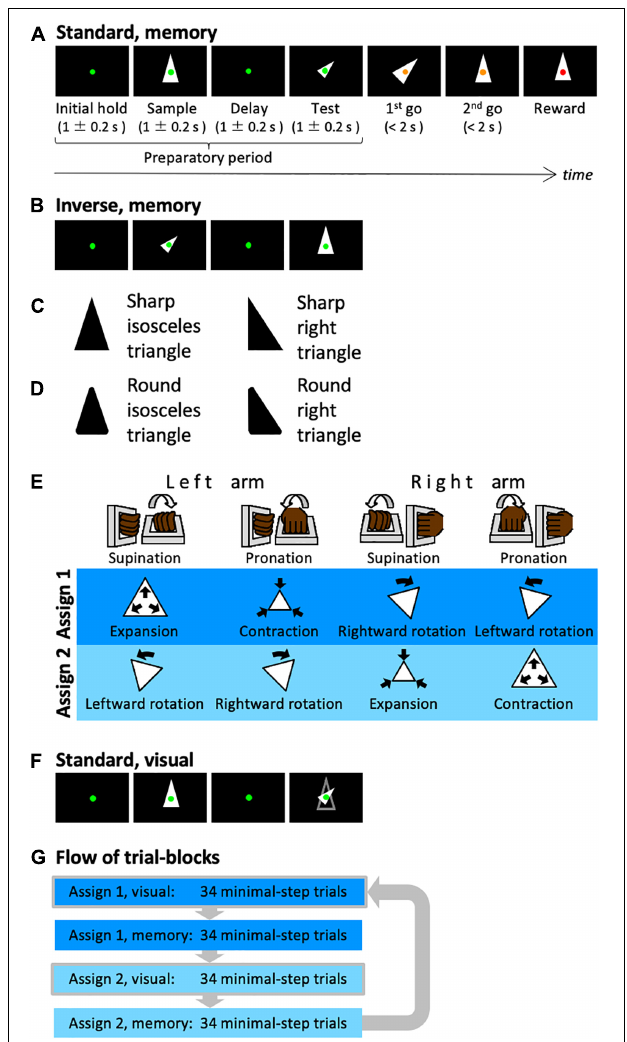
FIGURE 1 | Shape manipulation task. (A) The time-course of one trial. In this case, a shape with standard size and upward orientation was presented in the sample period, while the transformed shape was presented in the test period (standard version). (B) In this case, the transformed shape was presented in the sample period. (C) The types of the presented shapes. An isosceles or right triangle was used. (D) The local features of the presented shapes. Sharp or round corners were used. (E) Assignments between arm movements and manipulation of the shape. (F) In this case, the contour of the sample shape was presented in the test period (visual). The subject can recognize the transformation between the sample cue and the test cue visually, i.e., without memory. (G) Illustration of the composition of the trial